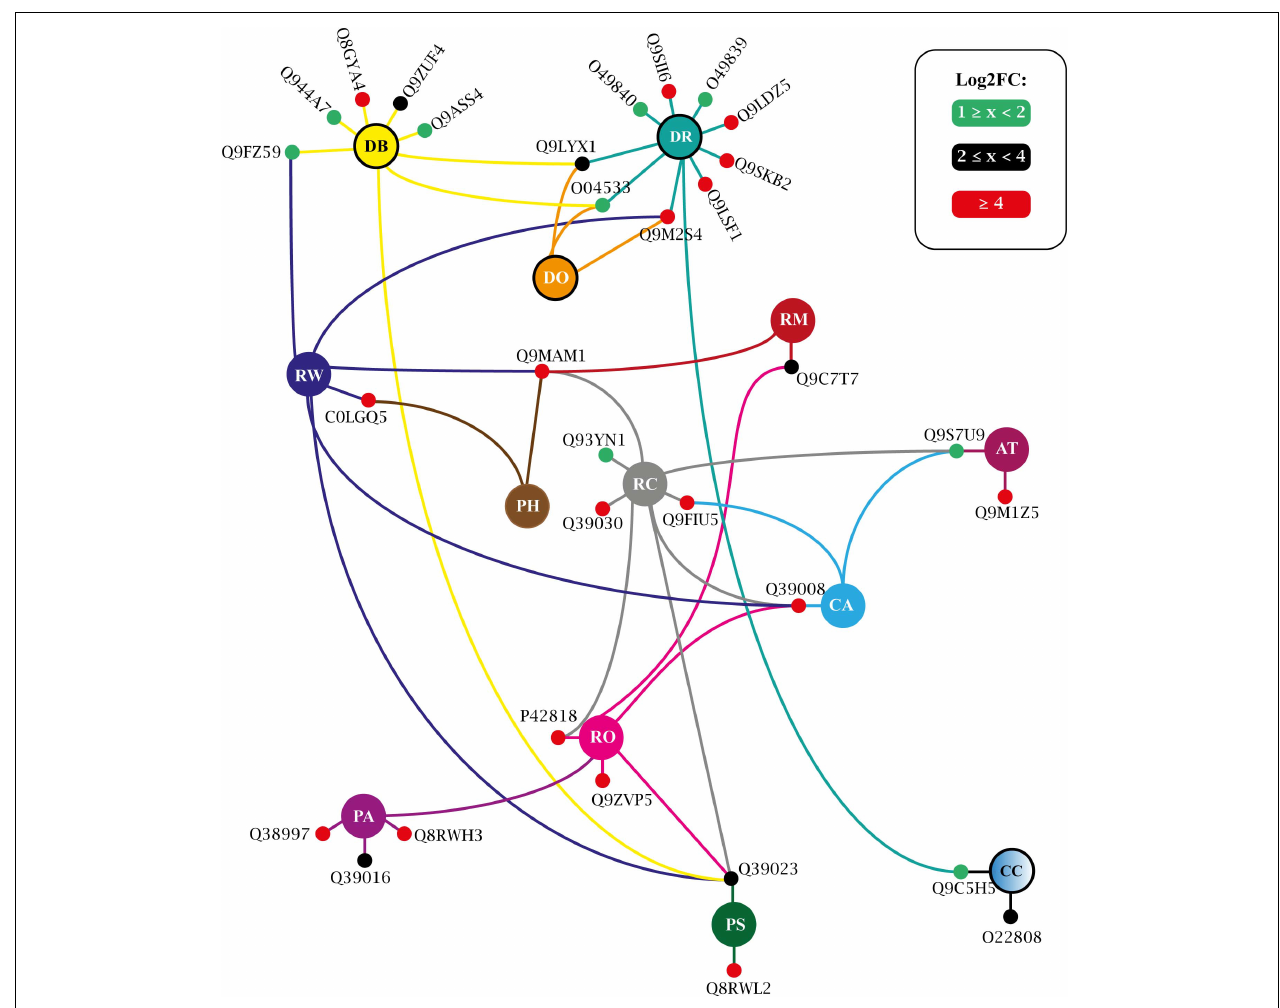
FIGURE 9 | Biological process enriched for T25 up-regulated VuPKs showing the interaction network (colored lines) of the associated elements (proteins). The colored dots (green, black, and red) in the protein Uniprot ID correspond to the fold-change log (log 2 FC) found in the present study and are according to the presented scale. The colors of the lines are associated with the colors of the central nodes that contain the abbreviation of the enriched biological process. Different colored lines connected to a given protein (colored dots—red, black, or green) indicate that this protein participates in different enriched processes. Central nodes with the border highlighted in black represent GO terms associated with the biotic stress response. T25, ‘RD25 vs. Cont.25’; GO terms enriched (AT, auxin transport; CC, cellular response to chitin; CA, cold acclimation; DR, defense response; DB, defense response to bacterium; DO, defense response to oomycetes; PA, positive regulation of abscisic acid-activated signaling pathway; PS, positive regulation of response to salt stress; PH, potassium ion homeostasis; RC, response to cold; RM, response to mannitol; RO, response to osmotic stress; RW, response to wounding; RD, root dehydration; Cont., control). Adapted from NeVOmics tool